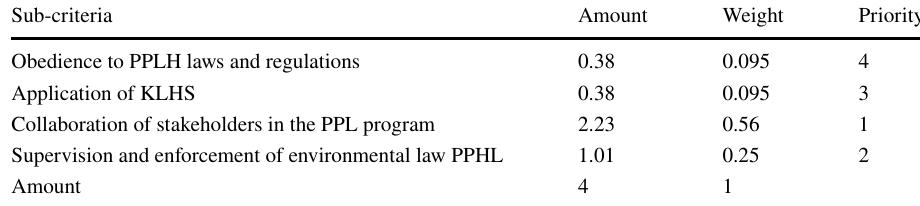
Table 16 Sub-priority criteria weighting